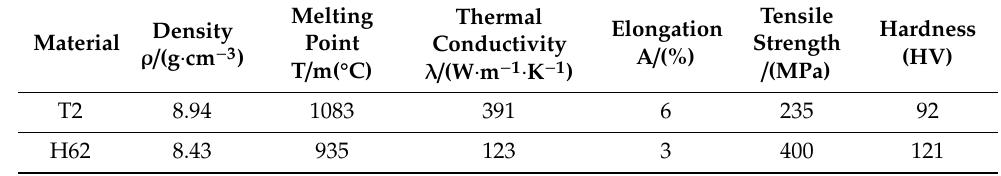
Table 2. Physical and mechanical properties of the material.